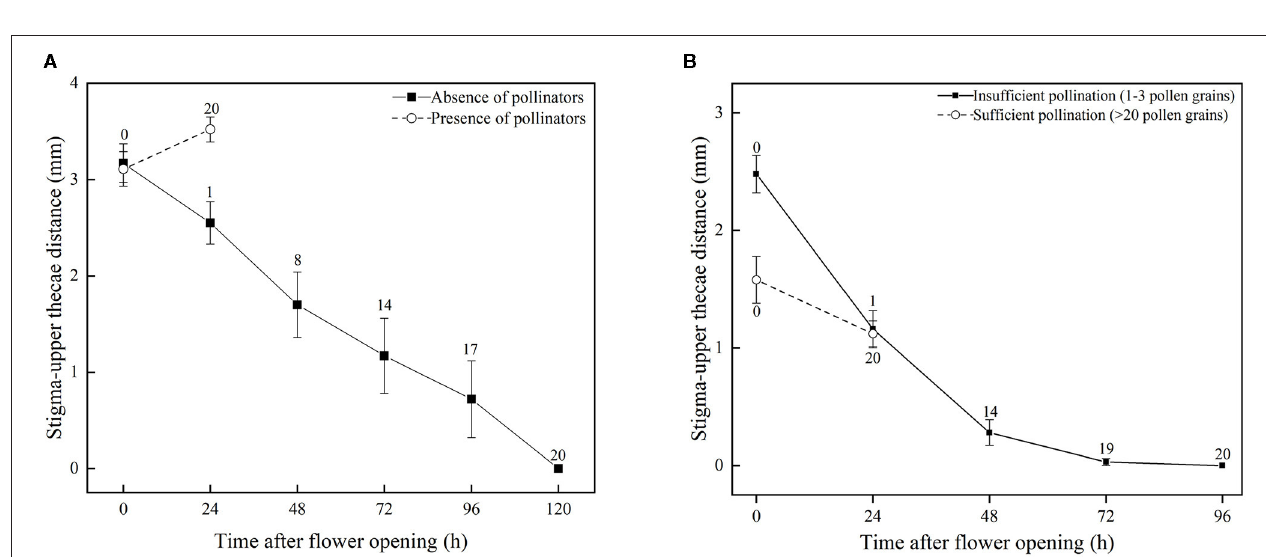
FIGURE 3 | Occurrence and prevention of DAS in S. umbratica (bars indicate standard errors). (A) Mean stigma-upper thecae distance of flowers in absence of pollinators and also after pollination by a pollinator (presence of pollinators). Records were taken when a flower first opened (0h) and thereafter at 24h intervals until pollination was completed in all flowers. Numbers above standard error bars indicate total number of flowers pollinated at given time. (B) Mean stigma-upper thecae distance of flowers subjected to insufficient pollination (stigmas hand-pollinated with 1–3 pollen grains) and sufficient pollination (hand-pollinated with > 20 pollen grains) treatments. Records were taken of stigma-upper thecae distance when a flower was pollinated with a mix of pollen grains causing either insufficient fertilization or sufficient fertilization (0h) and thereafter at 24h intervals. Numbers above standard error bars indicate total number of flowers self-pollinated (stigma-thecae distance, D = 0) at given